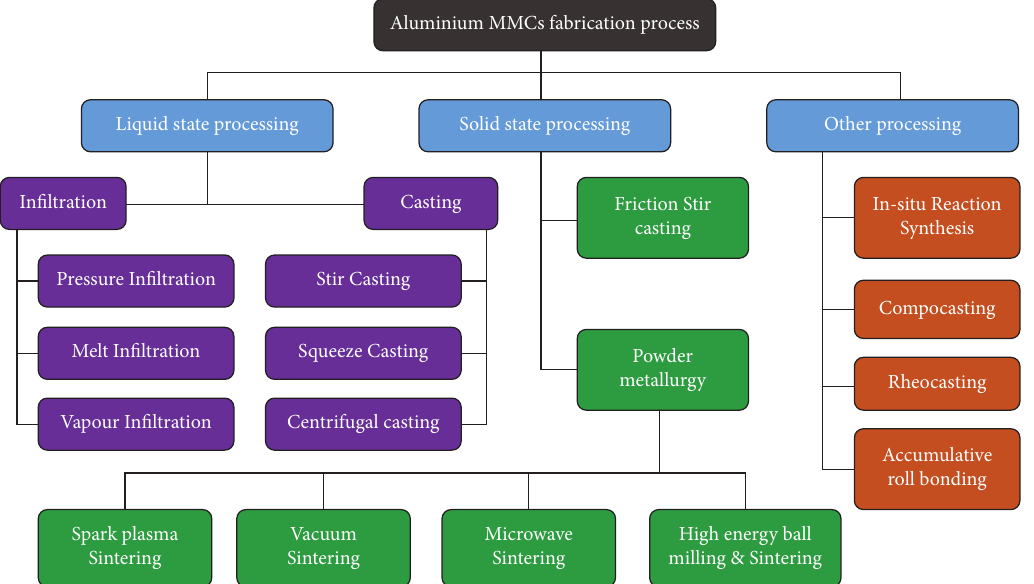
Figure 2: Classification of aluminum composites fabrication